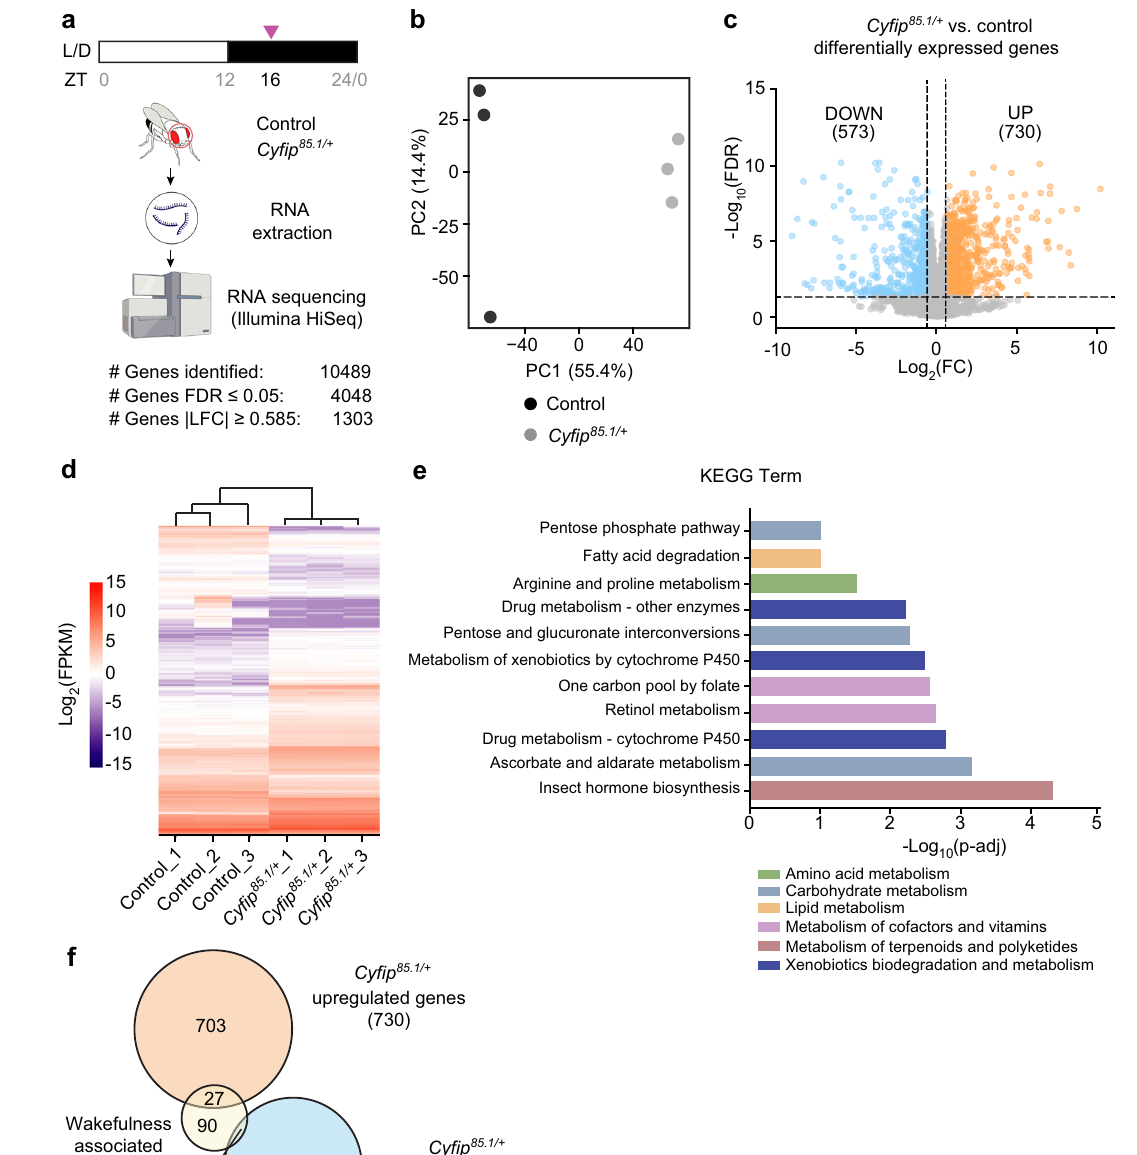
Fig. 3 | The Cy fi p mutant transcriptome revealed a dysregulation of energy metabolism. a Schematic of the experimental design. Listed is the number of genes that were identi fi ed and passed consecutive fi lters. Created with BioR- ender.com. b Principal component analysis of RNA-seq data. Samples are color- codedaccordingtothegenotype. n =3,where n =independentsamples,poolof20 fl y heads. c Volcano plot showing the global transcriptional changes in control vs Cy fi p 85.1/+ determined by RNA-seq. Moderated t test followed by the Benjamini- Hochberg method test for false discovery rate (FDR). Each circle represents one RNA, and colored circles represent differentially expressed genes (DEGs) sig- ni fi cantly upregulated (FDR ≤ 0.05 and LFC ≥ 0.585 (in orange)) or signi fi cantly downregulated (FDR ≤ 0.05 and LFC ≤− 0.585 (in blue)). d Heatmap representing